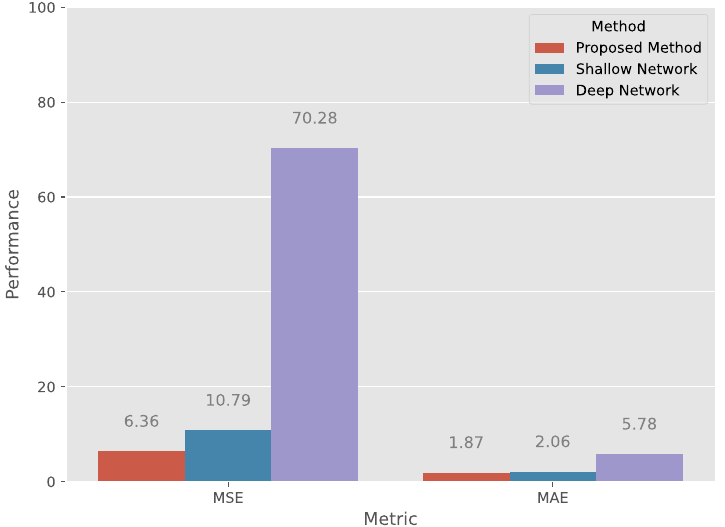
Figure 6. Performance of different network architectures, where a lower value is